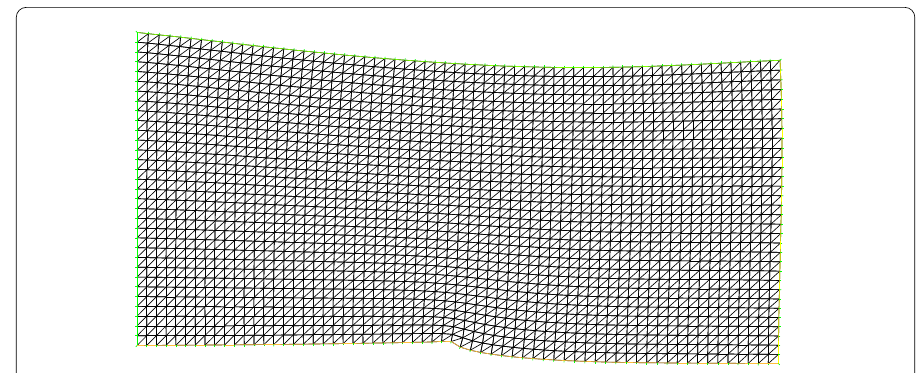
Figure 3 The configuration of (cid:2) at t = 1 s